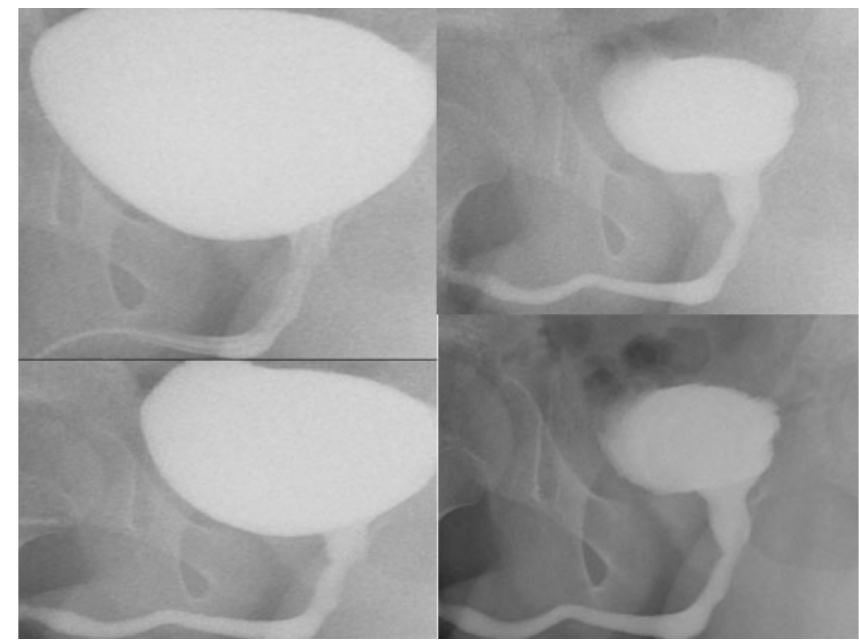
Fig. 2 Micturating cystourethrogram — note free re fl ux into the left vas deference from posterior urethra.